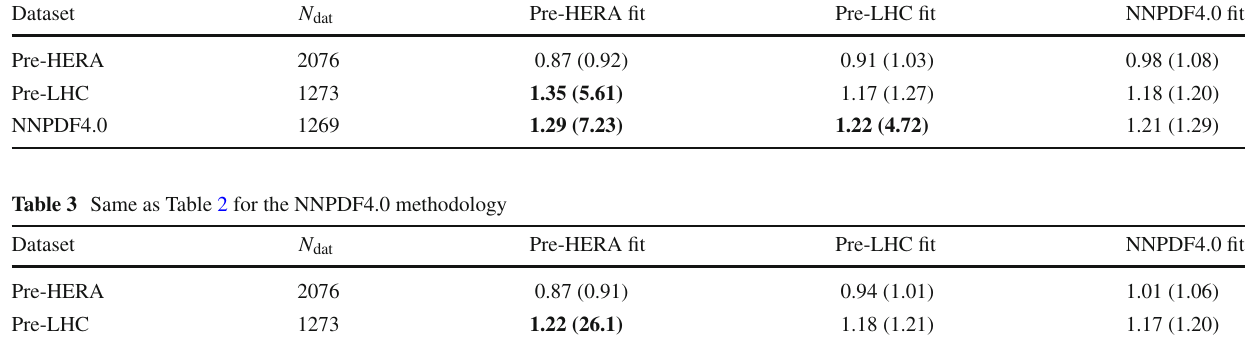
the NNPDF4.0 dataset only uses “post-LHC” data). The values in bold represent the performance on datasets that were not part of the training. The values inside parentheses correspond to a χ 2 defined with σ as defined in (9), while those without parenthesis are defined with only the experimental covariance matrix of (7)